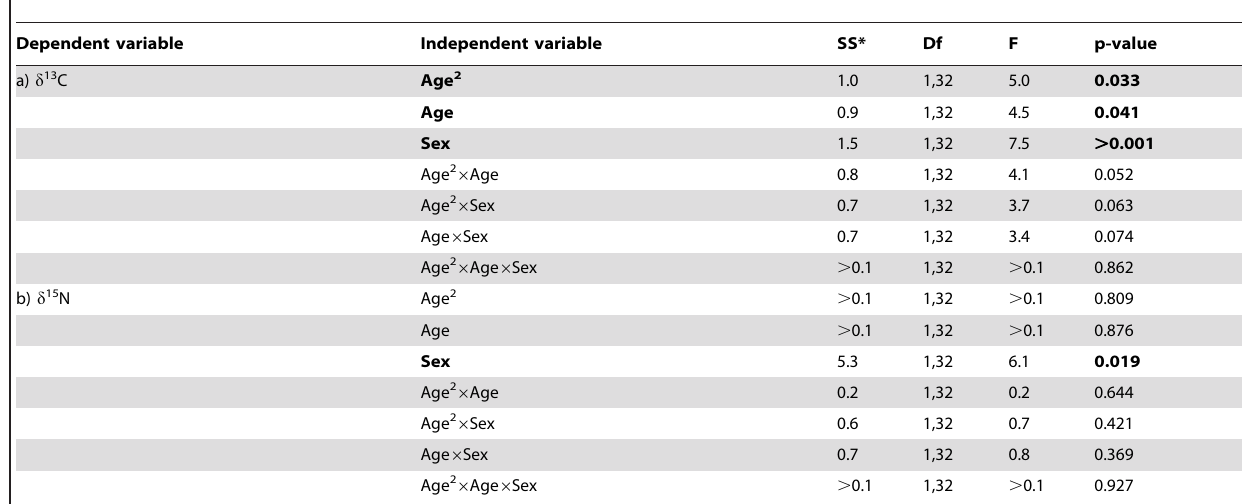
Table 2. Modelling the effects of age (years), age 2 , sex and interactions as a function of blood d 13 C and d 15 N values ( % ) in pre- laying snow